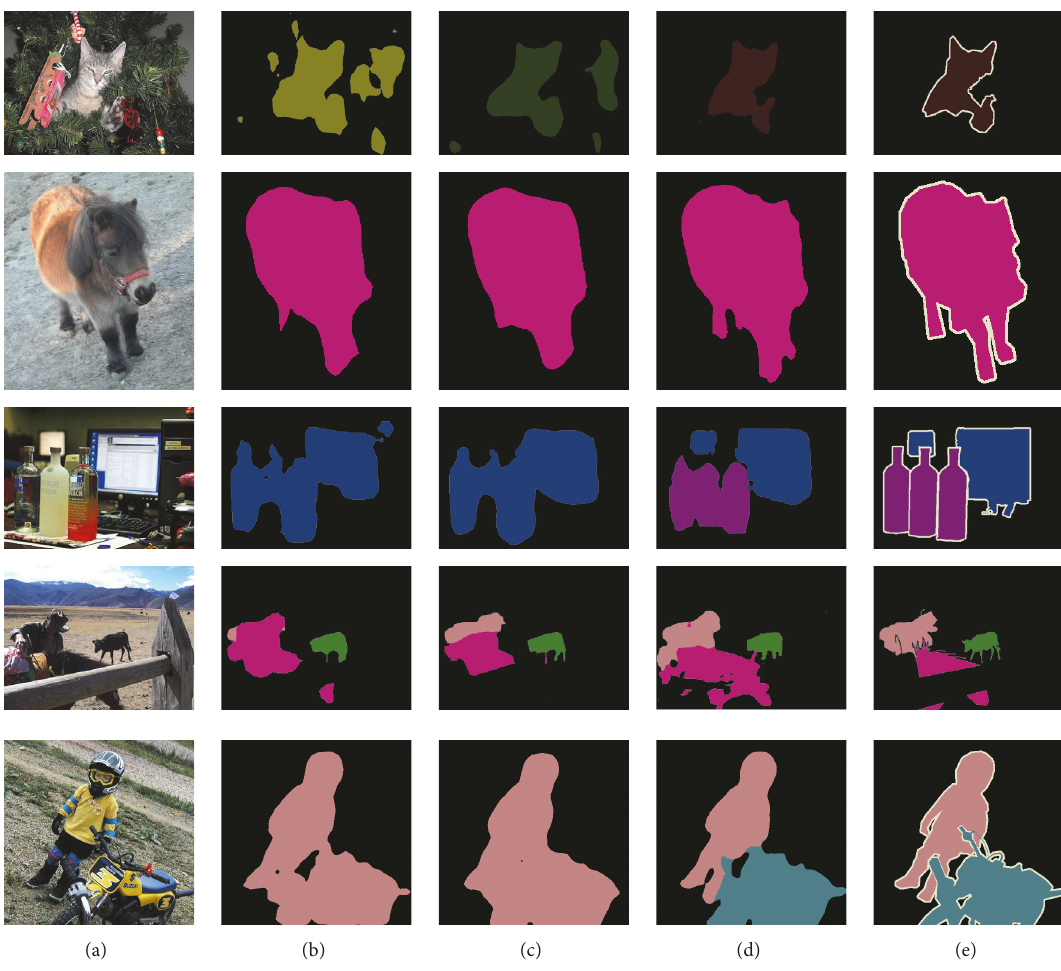
Figure 5: Comparison of different semantic segmentation algorithms on PASCAL VOC 2012: (a) original image; (b) FCN-8S; (c) DeepLab; (d) our method; (e) ground